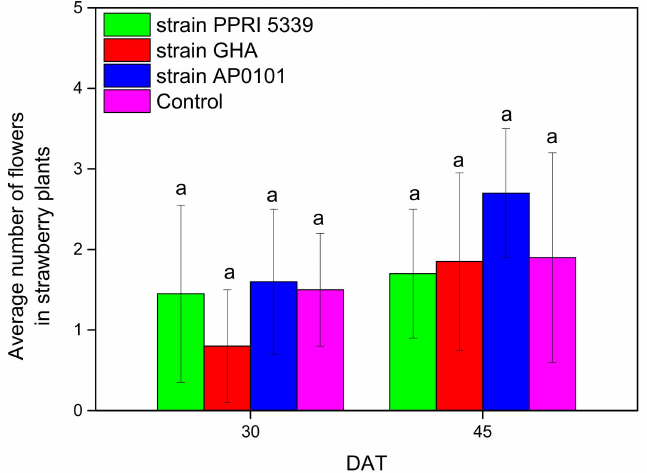
Figure 13. Average number of flowers per Fragaria sp. Plants inoculated with B. bassiana. Each treated plant was watered with 10 mL of 10 8 conidia/mL suspension at the stage of four leaves (November 2021), and after 4 months (March 2022), means of the same DAT marked with the same letter did not differ significantly (Tukey-Kramer test, p < 0.05); DAT: days after